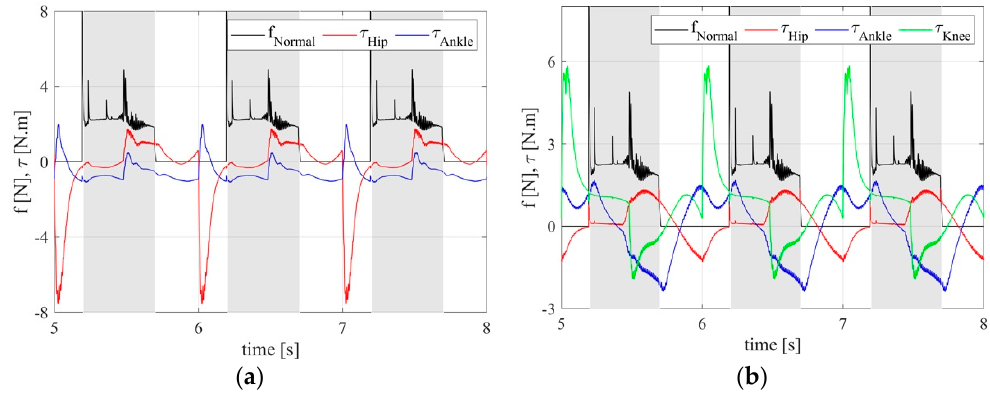
Figure 4. Normal force (NF) acting on the foot and pitch / roll torque value in a right limb: ( a ) NF and torque values according to the pitch-angle rotations in the yz -plane; ( b ) NF and torque values with respect to the roll-angle rotations in the xz -plane.